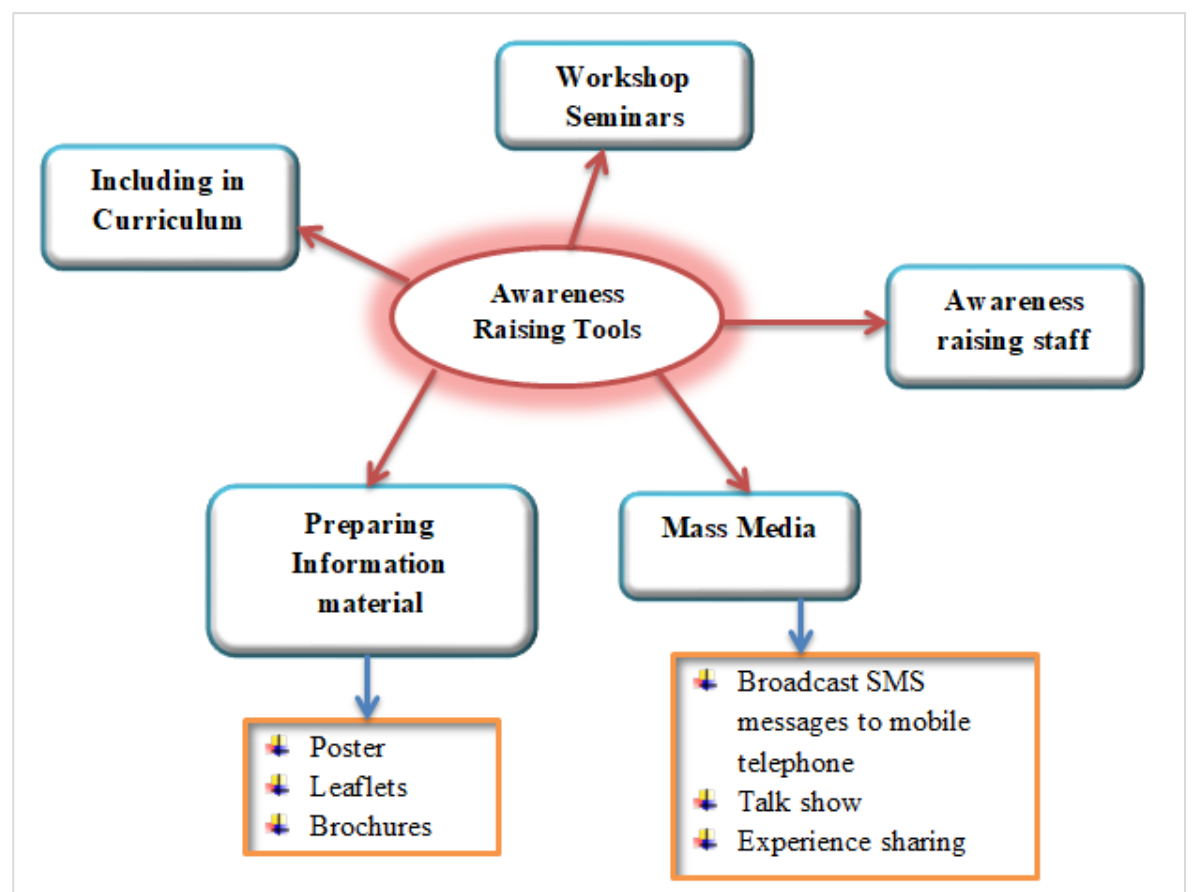
Figure 6. Tools for awareness raising.